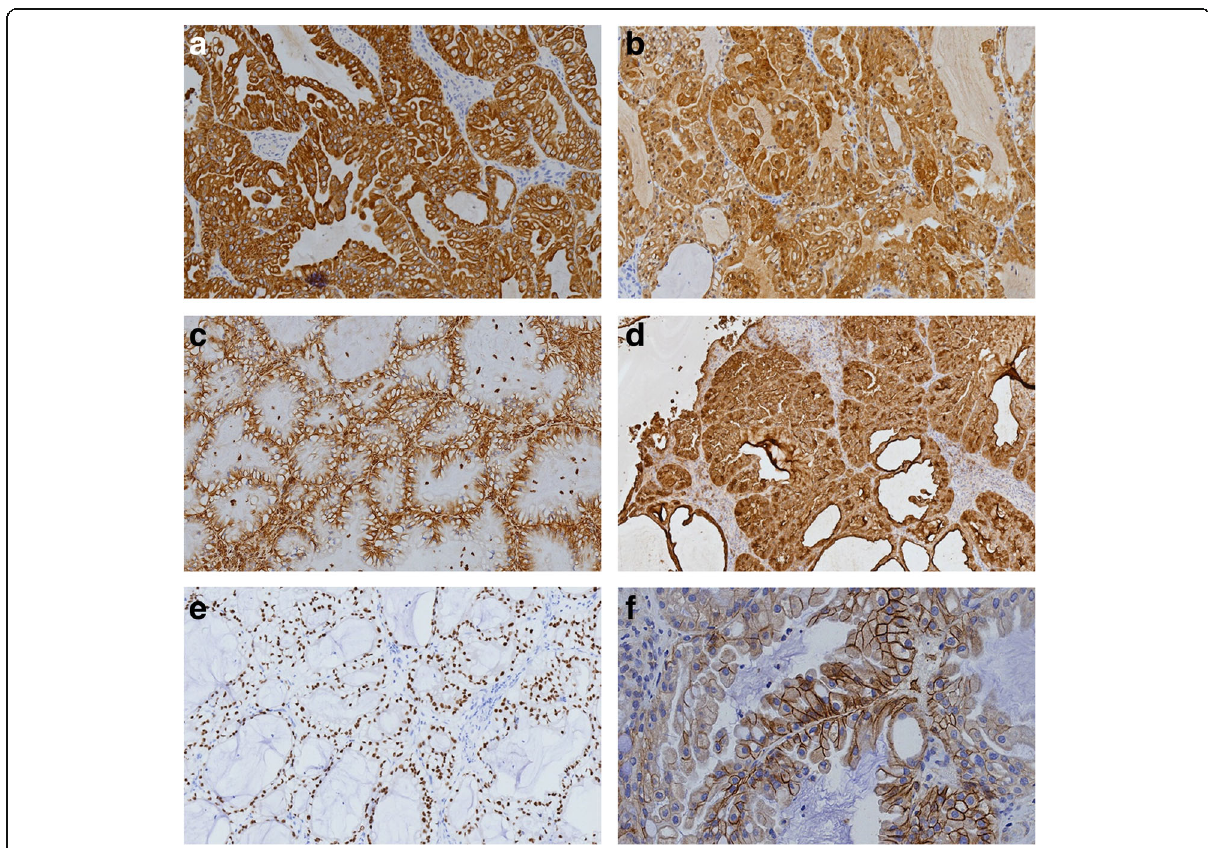
Fig. 3 a Immunohistochemical examination showed positive expression of CK7(magnification × 100). b Immunohistochemical examination showed positive expression S-100(magnification × 100). c Immunohistochemical examination showed positive expression of Vimentin (magnification × 200). d Immunohistochemical examination showed positive expression of EMA(magnification × 100). e Immunohistochemical examination showed nuclear positive expression of SOX10(magnification × 200). f Immunohistochemical examination showed focally positive expression of CA9(magnification ×